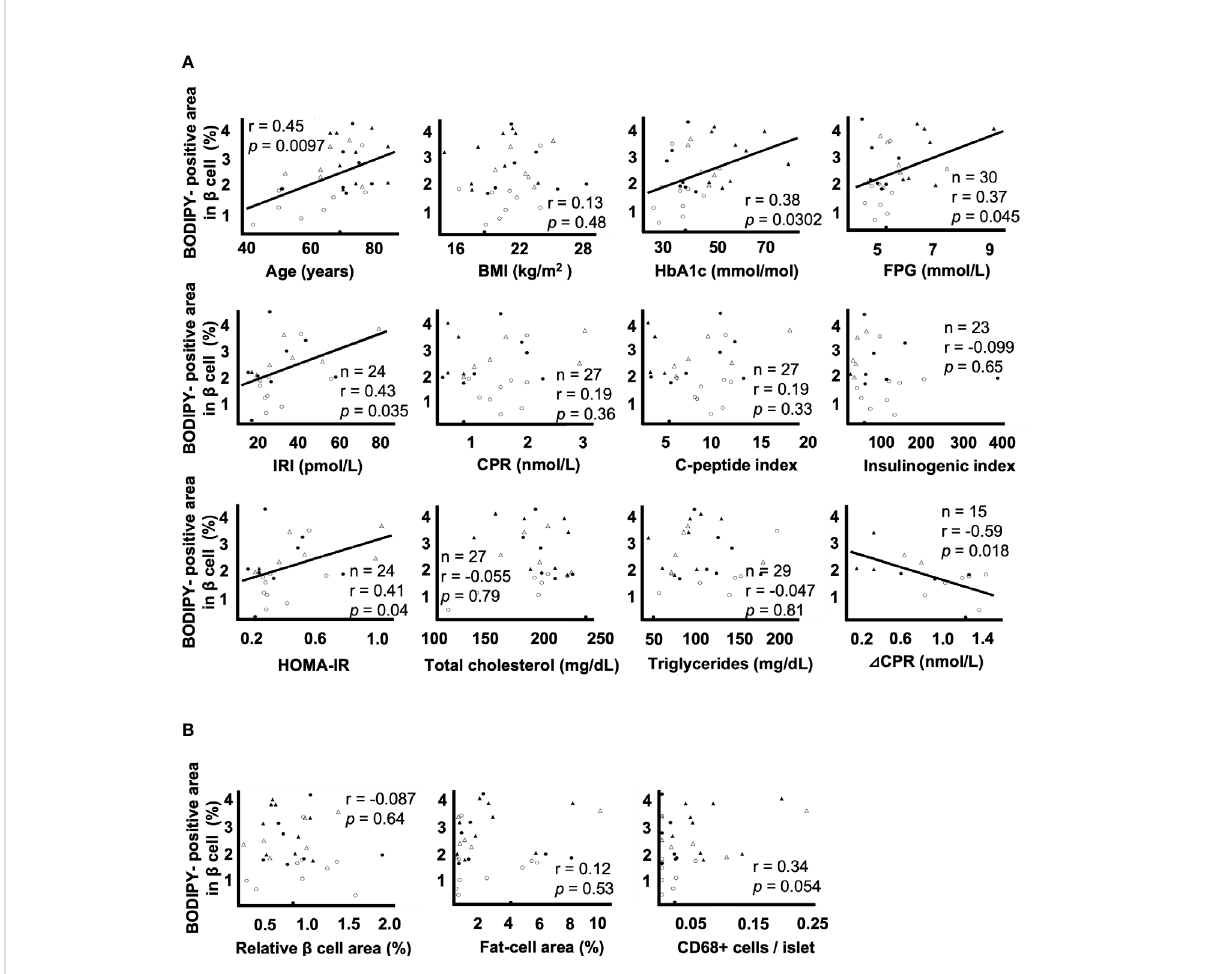
FIGURE 2 Correlation coef fi cients between lipid droplets (LDs) in b cells and clinical and histological parameters A : Correlation coef fi cients between the BODIPY-positive area in b cells and the parameters of age, BMI, HbA1c, FPG, F-IRI, F-CPR, C-peptide index, insulinogenic index, HOMA-IR, total cholesterol, triglycerides and D CPR. B : Correlation coef fi cients between the BODIPY-positive area in b cells and the relative b cell area, fat-cell area and CD68 + cells per islet. Open circles ( ○ ), the NGT group (n= 9); closed circles ( ● ), the IGT group (n= 8); open triangles ( Δ ), the newly diagnosed T2DM group (n= 6); closed triangles ( ▲ ), the preexisting T2DM group (n=